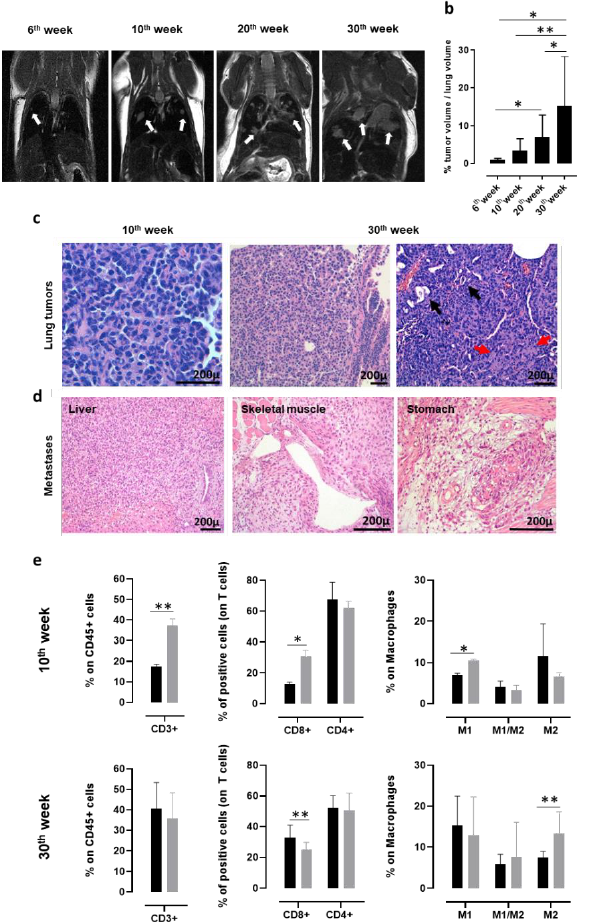
Figure 1. Characterization of lung cancer progression in K-Ras G12D mice. ( a ) Representative MRI images acquired with a 7T high field scanner of K-Ras G12D mice at 6, 10, 20, and 30 weeks of age (N = 3 mice for each time point). White hyperintense regions, indicated by arrows, are tumors. ( b ) Percentage (mean + standard deviation (SD)) of tumor volume occupying the lungs of K-Ras G12D mice (N = 5–16) at indicated weeks of age. Statistically significant differences were calculated using the Student’s t -test: *, 0.05; **, 0.008. ( c ) Representative hematoxylin and eosin (H&E) evaluation of lung sections from K-Ras G12D mice at the initial (10 weeks of age, left panel) and late (30 weeks of age, middle, and right panels) stages of tumor progression. Black arrows indicate some figures of microglandular formation; red arrows indicate collagen deposition in desmoplastic stromal reaction. N = 4 mice were analyzed at indicated time points. ( d ) Representative H&E images of extrathoracic metastatic lesions in the liver, skeletal muscle, and stomach, collected from a 48-week-old K-Ras G12D mouse. N = 4 mice were analyzed. ( e ) Cytofluorimetric analysis of immune infiltrates of the lungs (N = 3–12) from 10 (upper panels) and 30-week-old (lower panels) wt (black bars) and K-Ras G12D (grey bars) mice. Graphs show the percentage ± SD of CD45 + cells expressing CD3 (left panels), CD8, and CD4 (middle panels) and of the M1 state (CD11b + f4/80 + MHCII + CD206 - ), M2 state (CD11b + f4/80 + MHCII - CD206 + ), and M1/M2 transitional state (CD11b + f4/80 + MHCII + CD206 + ) macrophages (right panels). Statistically significant differences were calculated using the Student’s t -test: *, 0.01; **, <0.005.